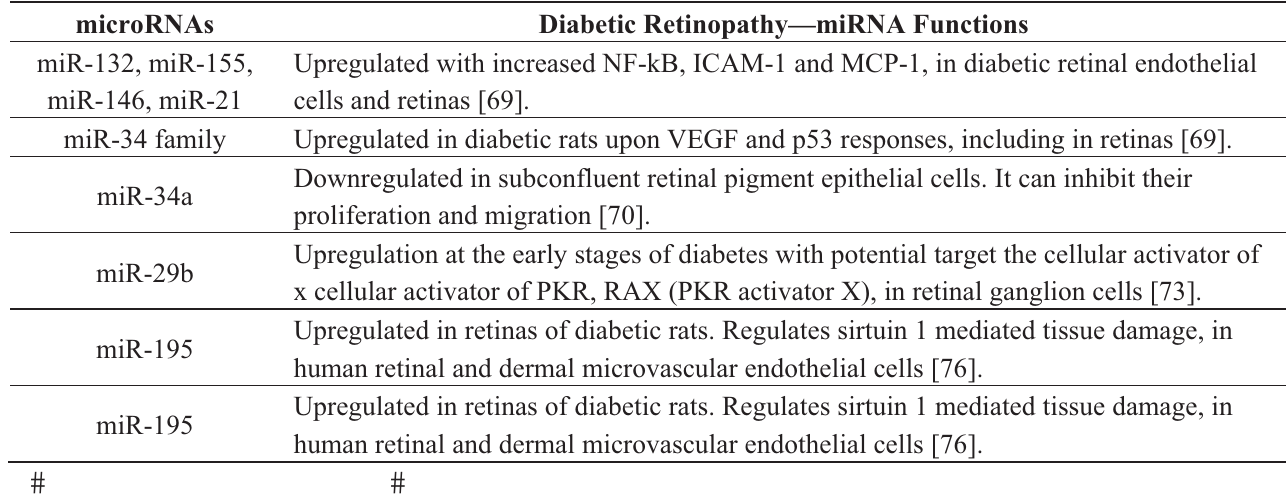
Table 1. Summary of miRNAs that are involved in diabetic